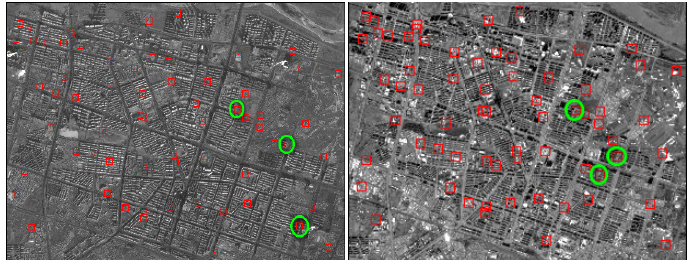
Figure 7. The matching result produced from the developed method, the correspondences are marked by red rectangles, and the outliers are marked by green circles.